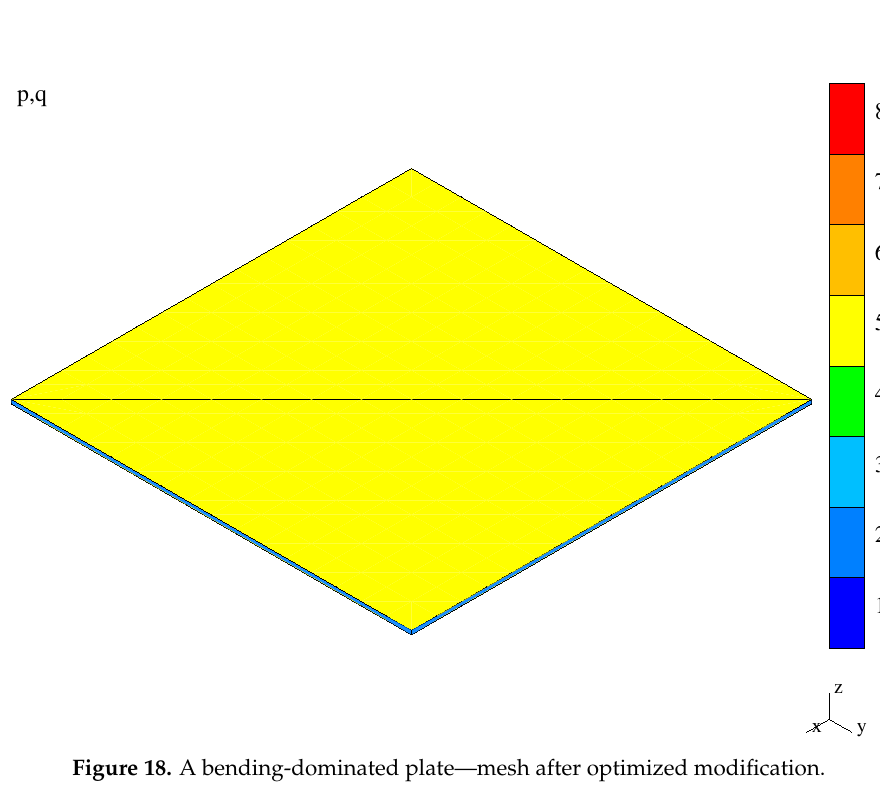
Figure 18. A bending-dominated plate—mesh after optimized modification.